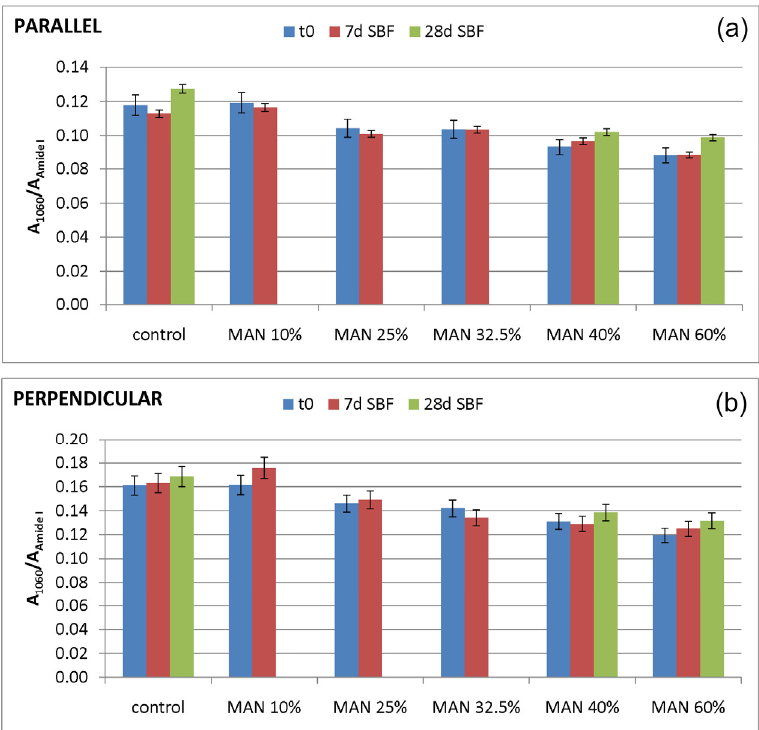
Figure 16. Values of the A 1060 /A Amide I absorbance ratio as obtained from the IR spectra recorded in the parallel ( a ) and perpendicular ( b ) orientations on the samples under study (control = untreated fibers, and MAN-grafted fibers containing different amounts of MAN) before (t0) and after ageing of the fibers in SBF.